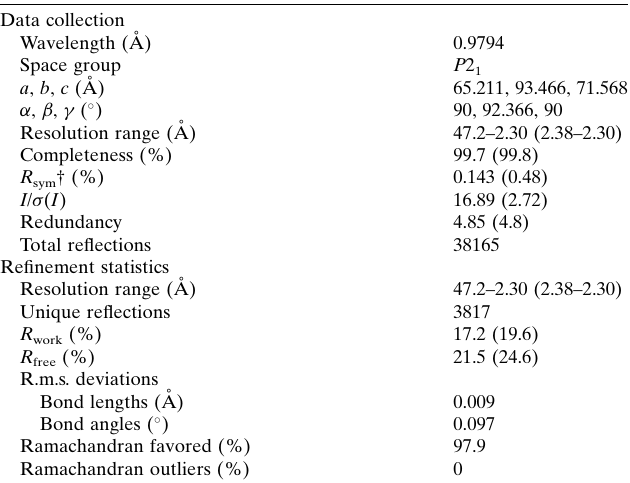
Table 1 Data-collection and refinement statistics for h MICAL3 FMOCH . Values in parentheses are for the highest resolution